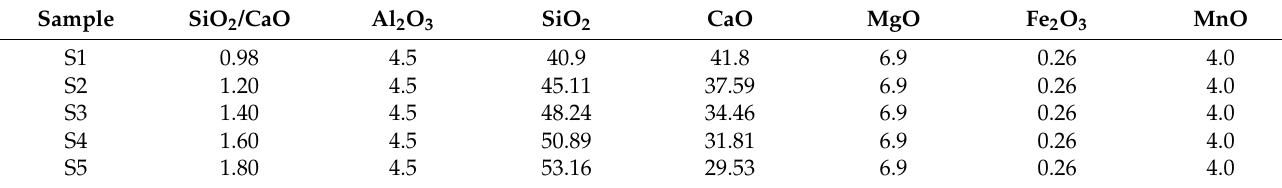
Table 2. Oxide composition of glass